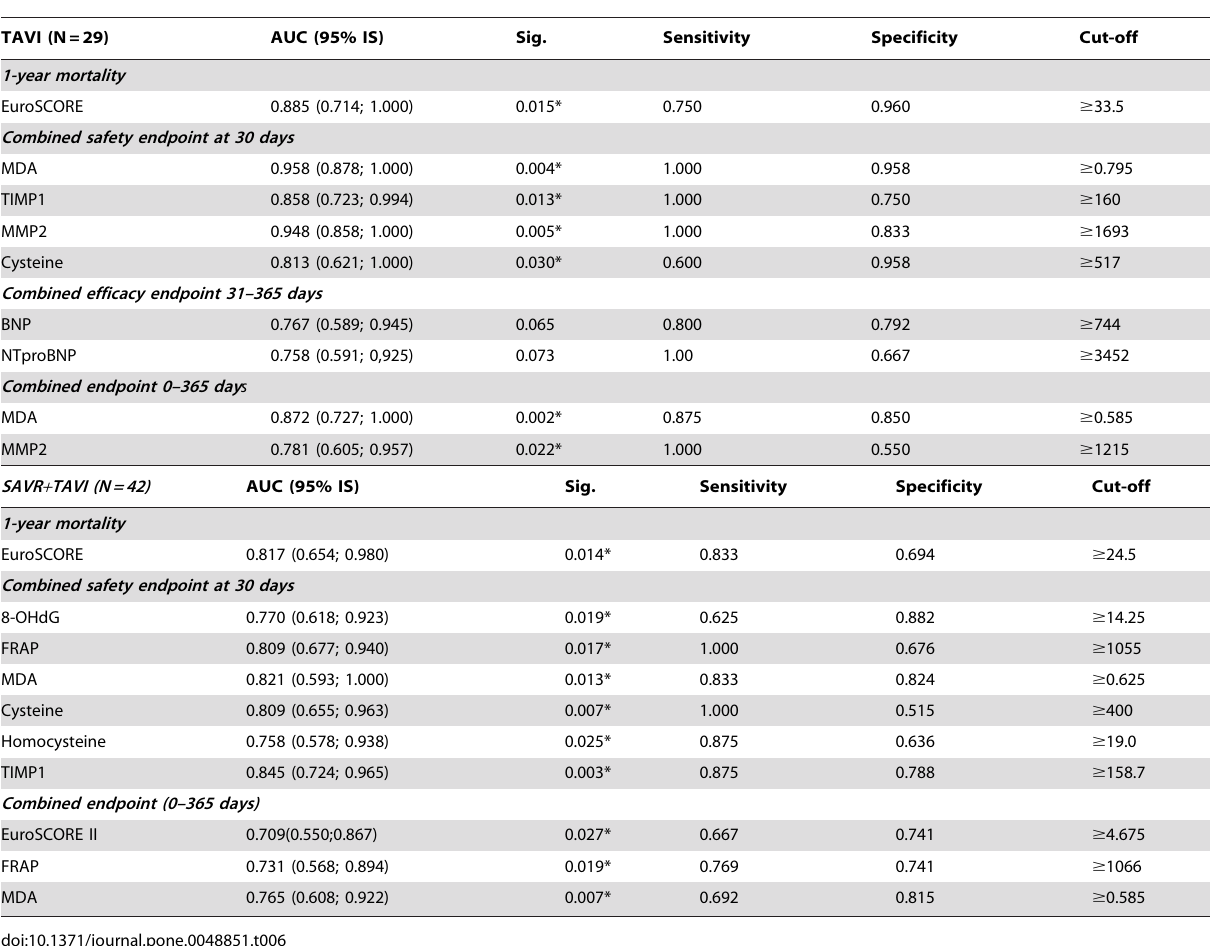
TAVI (N=29) AUC (95% IS) Sig. Sensitivity